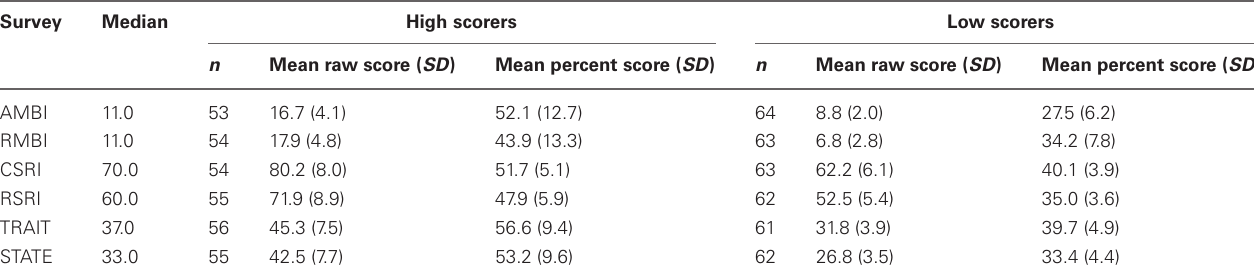
Table 3 | Summary of eyeblink conditioning groups made for comparison of high and low scores on AMBI, RMBI, CSRI, RSRI, STAI-Trait and STAI-State ( n =